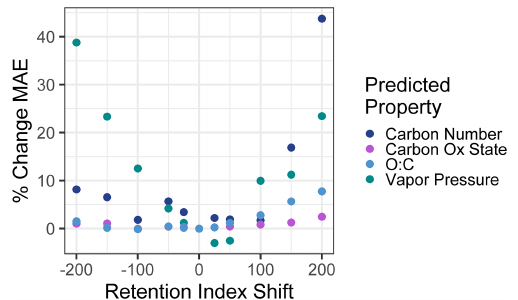
Figure 8. Percent increases in the mean absolute error in chemical property prediction as a function of the shift in a test set retention index relative to the training set retention index. Retention indices are normalized to a linear alkane series, making an increment of 100 indicate the retention time differences between two linear alkanes separated by one carbon number.